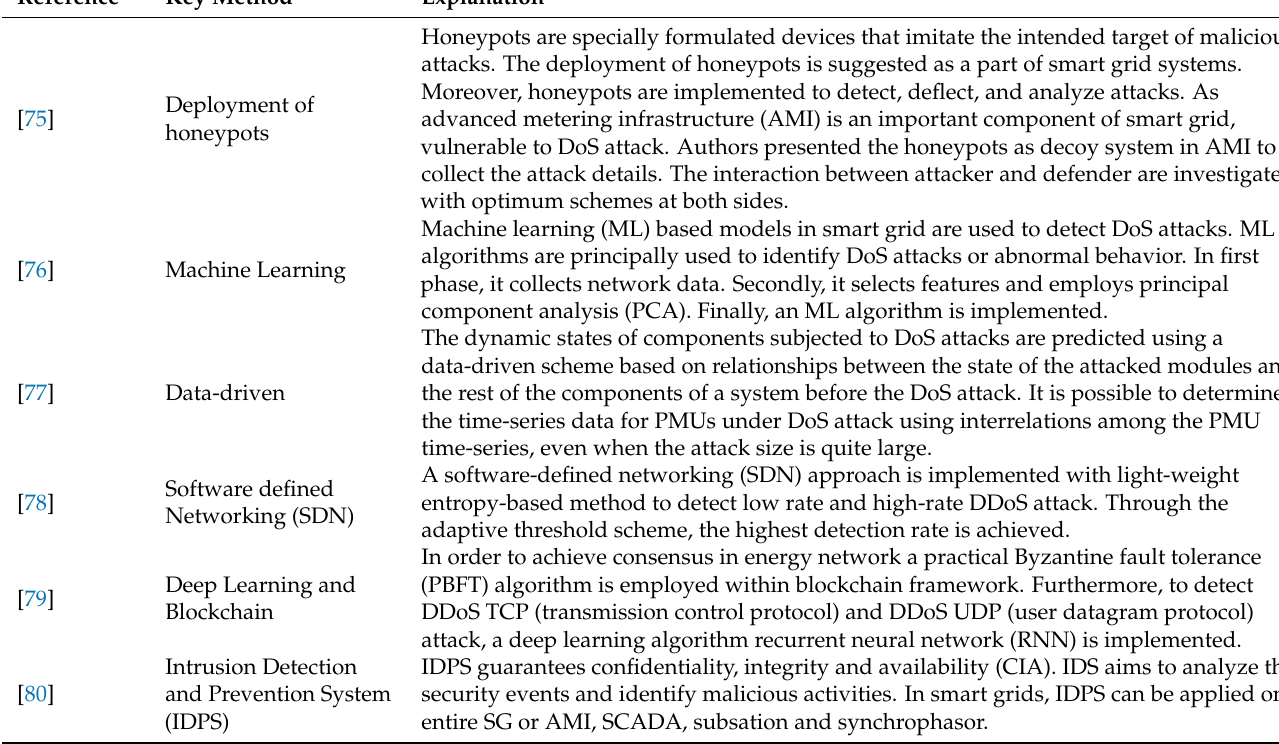
Table 4. Methods and countermeasures to defend against DoS